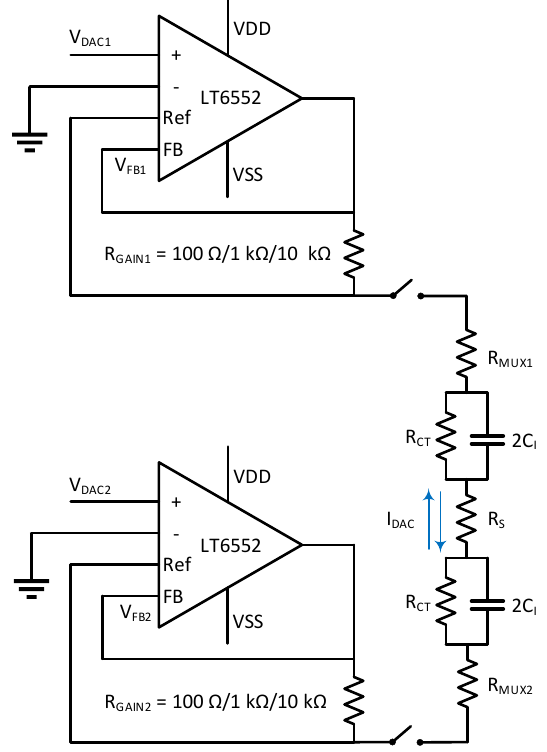
Figure 2. Bipolar current source